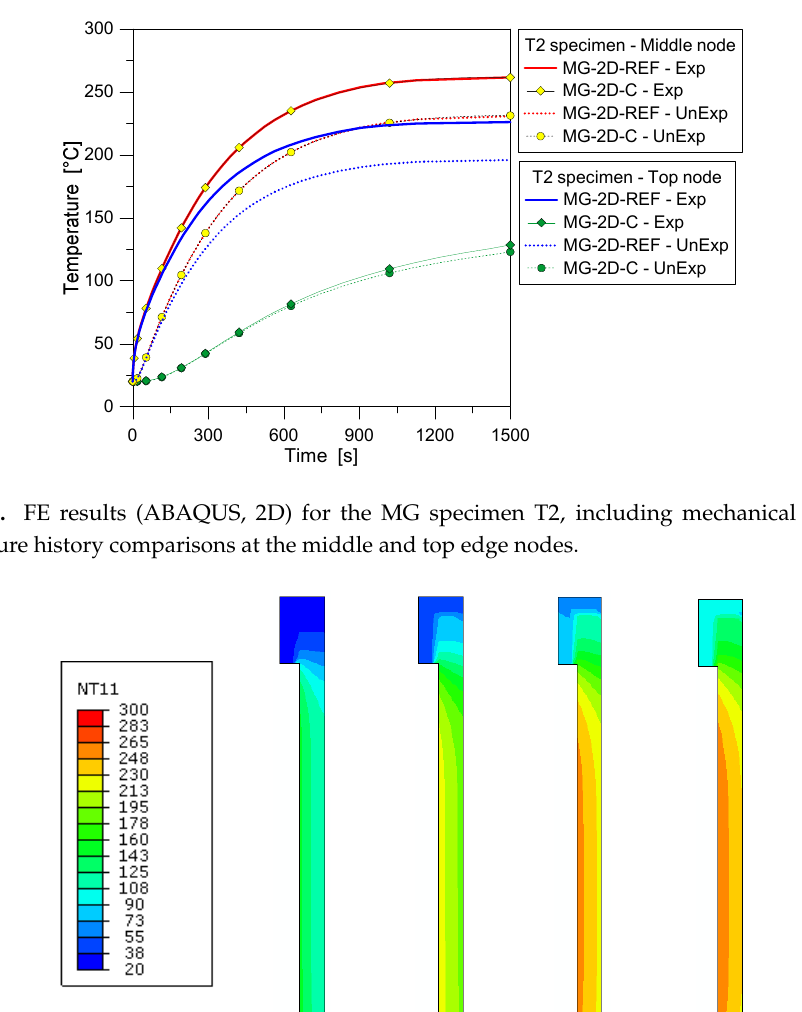
Figure 16. Temperature contour plots at different stages of the thermal simulation (ABAQUS, 2D), as obtained for the T2 sample with clamped edge. Temperature values are given in °C, after ( a ) 250 s; ( b ) 500 s; ( c ) 1000 s and ( d ) 1500 s of loading.